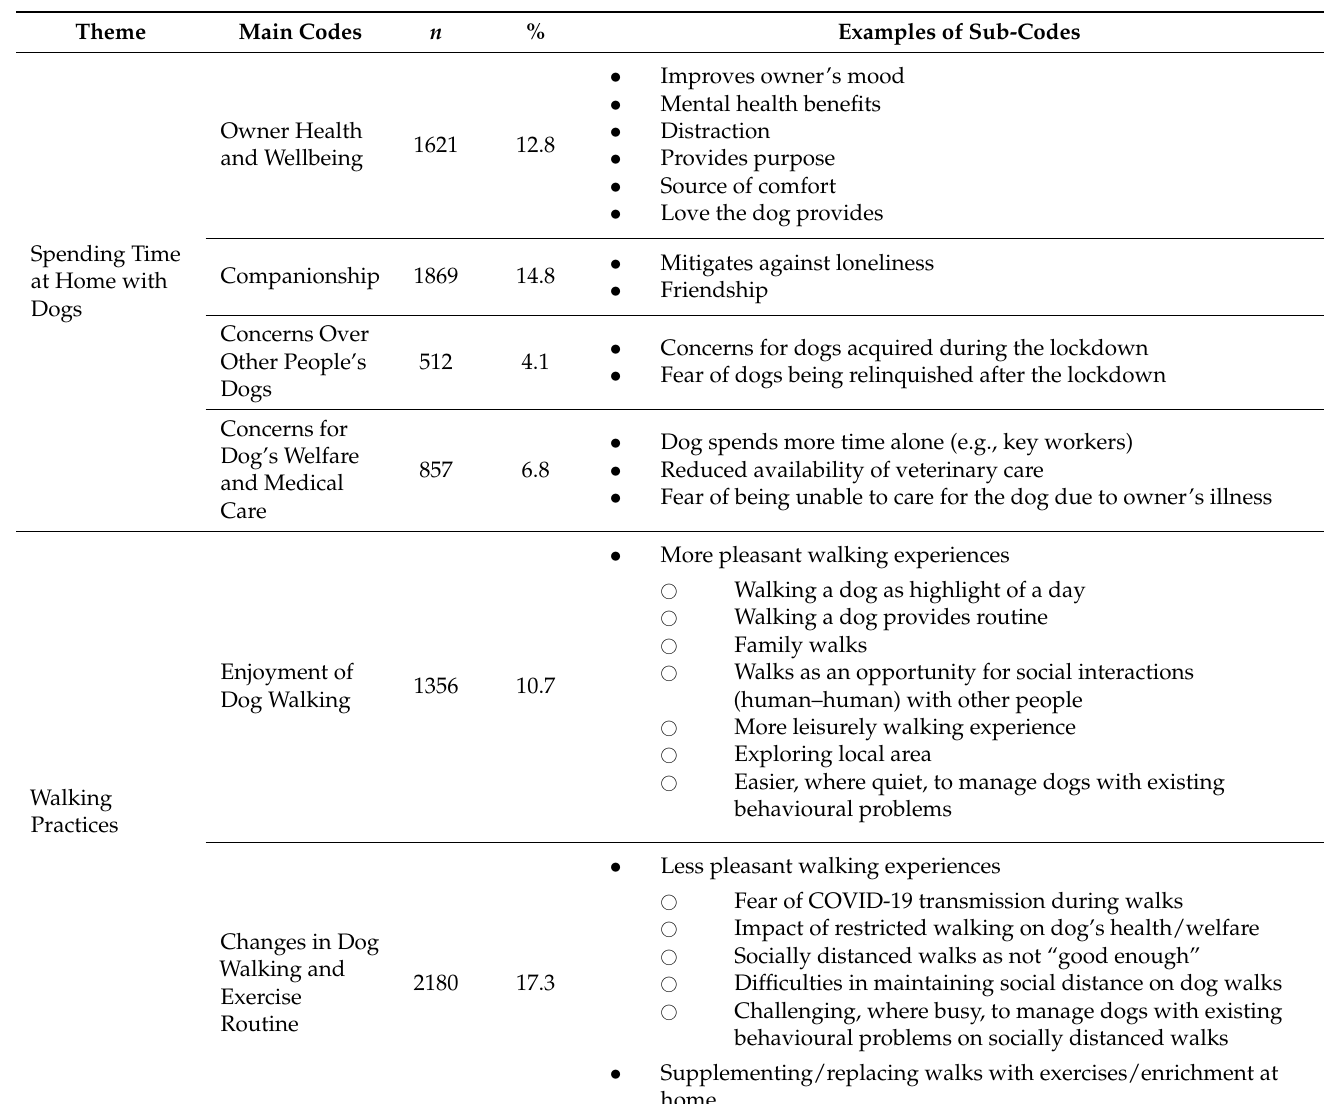
Table 2. An overview of major themes and codes identified in the course of analysis. The number of times each main code was applied to survey response data is provided ( n ) alongside a percentage which reflects the proportion of the main codes that each main code accounts for (%). The number and percentage calculations are based on the survey content only; the main codes and sub-codes were, however, present also across the general population and Generation Pup diaries. Theme Main Codes n % Examples of